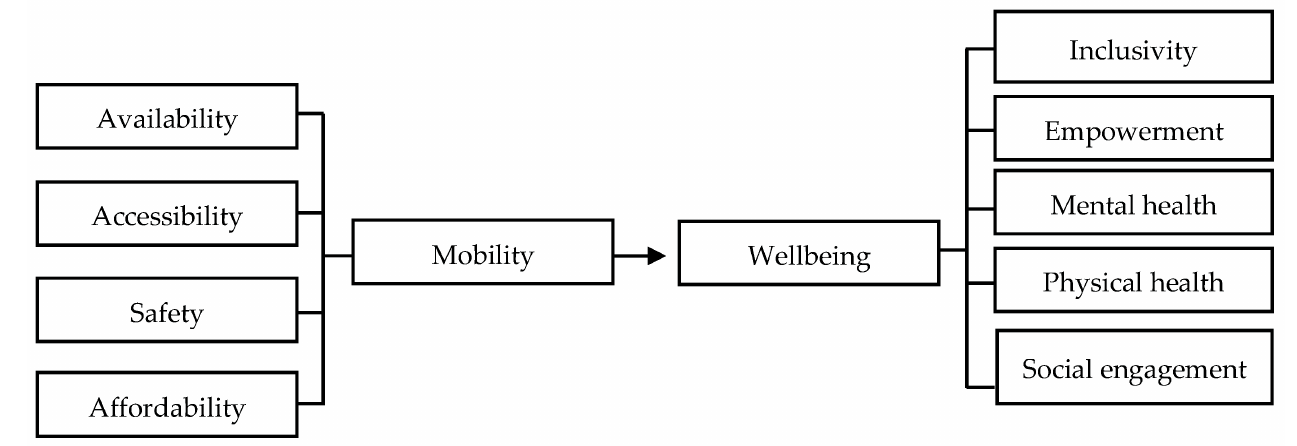
Figure 2. The relationship between private chauffeuring and companionship with the wellbeing of older adults. Note. Source: Authors, adapted from Cuignet, et al. [74].